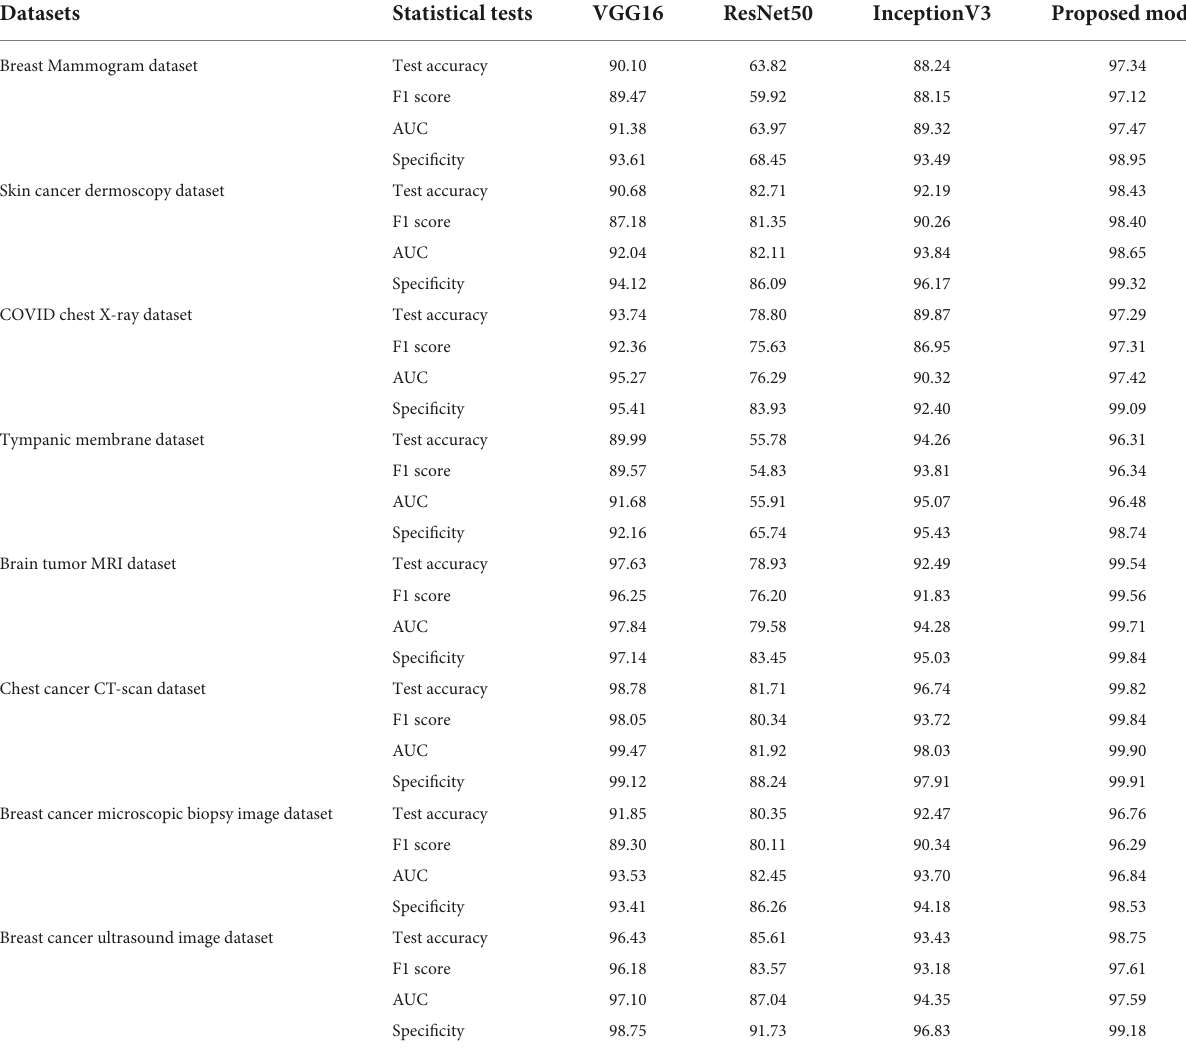
TABLE 6 Results of VGG16, ResNet50, InceptionV3, and MNet-10 on breast mammogram, skin cancer, chest X-ray, tympanic membrane, brain tumor MRI, chest cancer CT scan, and breast cancer ultrasound image with photometric augmentation techniques and breast cancer microscopic biopsy image with geometric augmentation